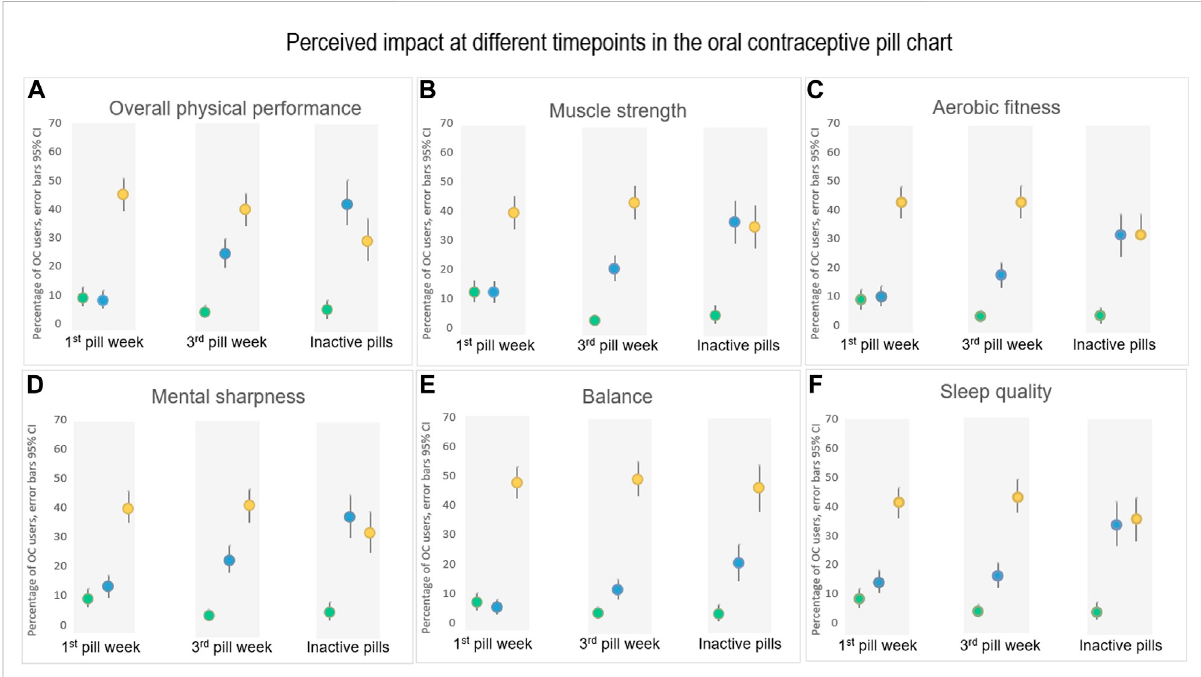
FIGURE 5 The perceived impact (positive, negative or no change) of (A) Overall physical performance, (B) Muscle strength, (C) Aerobic fi tness, (D) Mental sharpness, (E) Balance, and (F) Sleep quality, during different time points in the pill chart of combined hormonal contraceptives. First and third pill week ( n = 307) and at the time point for inactive pills ( n = 163). A proportion of 18% – 46% of the athletes answered “ I do not know ” on perceived impact for the different modalities, respectively (data not